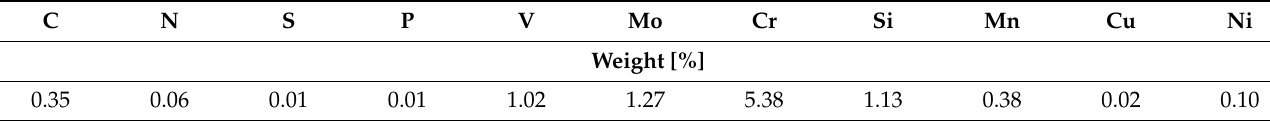
Table 4. H13 tool steel chemical composition.